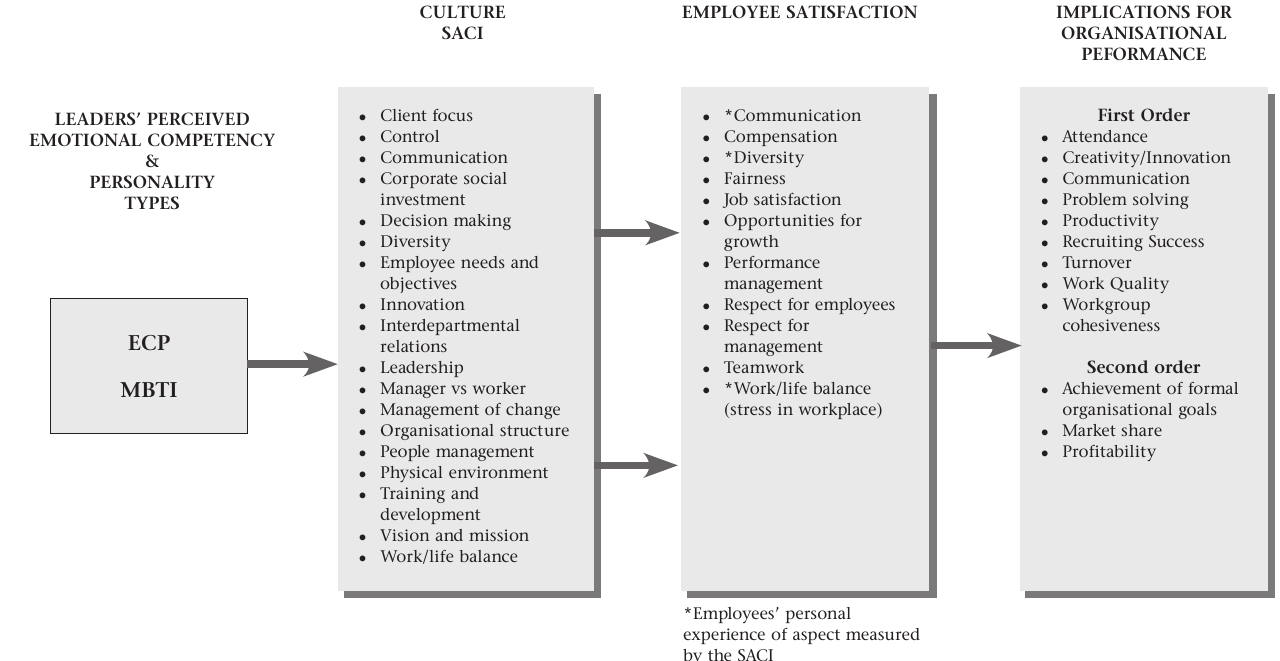
Figure 1: Overview of